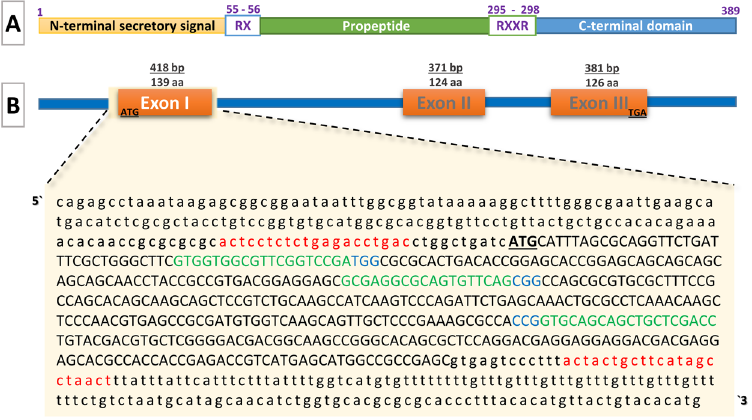
Figure 1. Design of the CRISPR/Cas9 system. ( A ) Schematic diagram of channel catfish MSTN; a signal sequence (N-terminal secretory signal), a propeptide domain (propeptide) and a bioactive domain (C-terminal domain). RX (55–56) is a proteolytic site to remove the signal sequence and RXXR (295–298) is a proteolytic processing site (RSSR) to produce C- terminal bioactive form of MSTN. These 3 domains (389 amino acids) are encoded from ( B ) the three exons of the channel catfish MSTN gene; Exons I, II and III consist of 418, 371 and 381 base-pairs encoding 139, 124 and 129 amino acids residues, respectively. CRISPR/Cas9 target sites in Exon I; The Exon and Introns are indicated by upper and lower case, the underlined Bold uppercase are the start and stop codons, The primers used in PCR are indicated in red, The guide RNA target sites are indicated in green followed by PAM (Protospacer adjacent motif, NGG) in